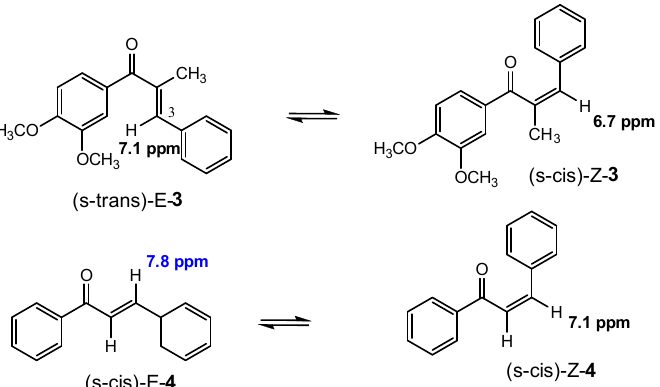
Figure 1. Structure of the α-methyl E -chalcone 3 (s-trans configuration) in the crystal.